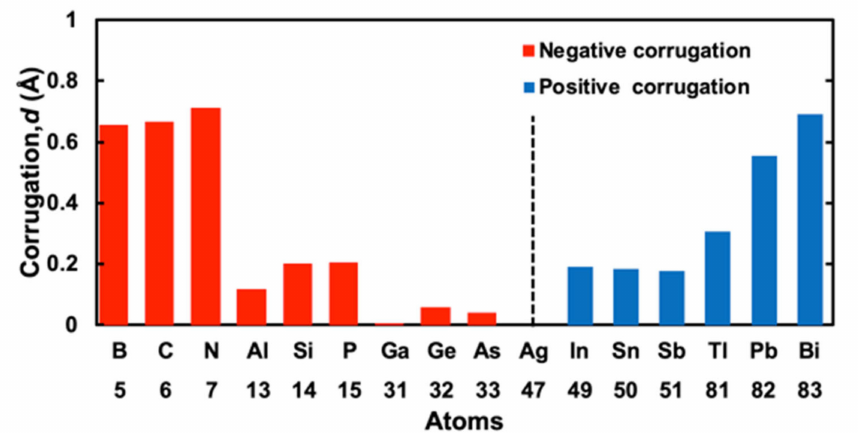
Figure 2. Summary of calculated corrugation parameter d of M atoms that consist of group III, IV, and V atoms, sorted by atomic number Z. Red and blue bars correspond to negative and positive values,